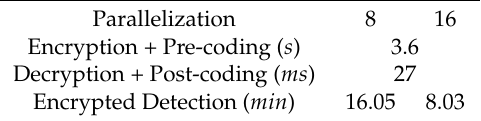
Table 1. Performance of Encrypted PRNU detection ( bit security > 128